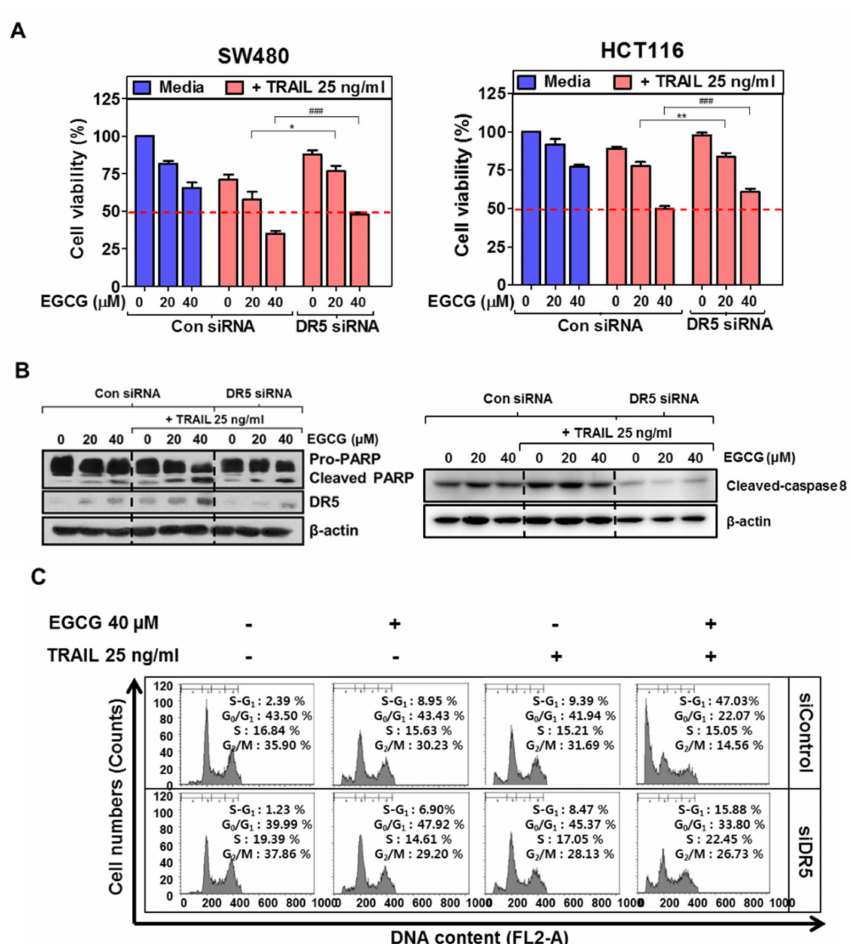
Figure 4. Depletion of DR5 blocks apoptosis induced by EGCG and TRAIL cotreatment in SW480 and HCT116 cells. ( A ) SW480 and HCT 116 cells were transiently transfected with control siRNA or DR5 siRNA plasmids and exposed to TRAIL (25 ng / ml) and EGCG (20 and 40 µ M) for 24 h. Cell viability was measured by MTT assay. * p < 0.05, ** p < 0.01 vs. DR5 siRNA control at 20 µ M of EGCG. ### p < 0.01, vs. DR5 siRNA control at 40 µ M of EGCG. ( B ) SW480 cells were transfected with DR5 siRNA plasmid and treated with EGCG and / or TRAIL for 24 h. The lysates were subject to Western blotting for PARP, DR5 and β -actin. ( C ) E ff ect of DR5 silencing on sub-G1 population by cotreatment of EGCG and TRAIL in SW480 cells. FACS analysis was conducted for sub-G1 accumulation in DR5-depleted SW480 and HCT116 cells following exposure to cotreatment of EGCG and TRAIL for 24 h / mL. Redline indicates